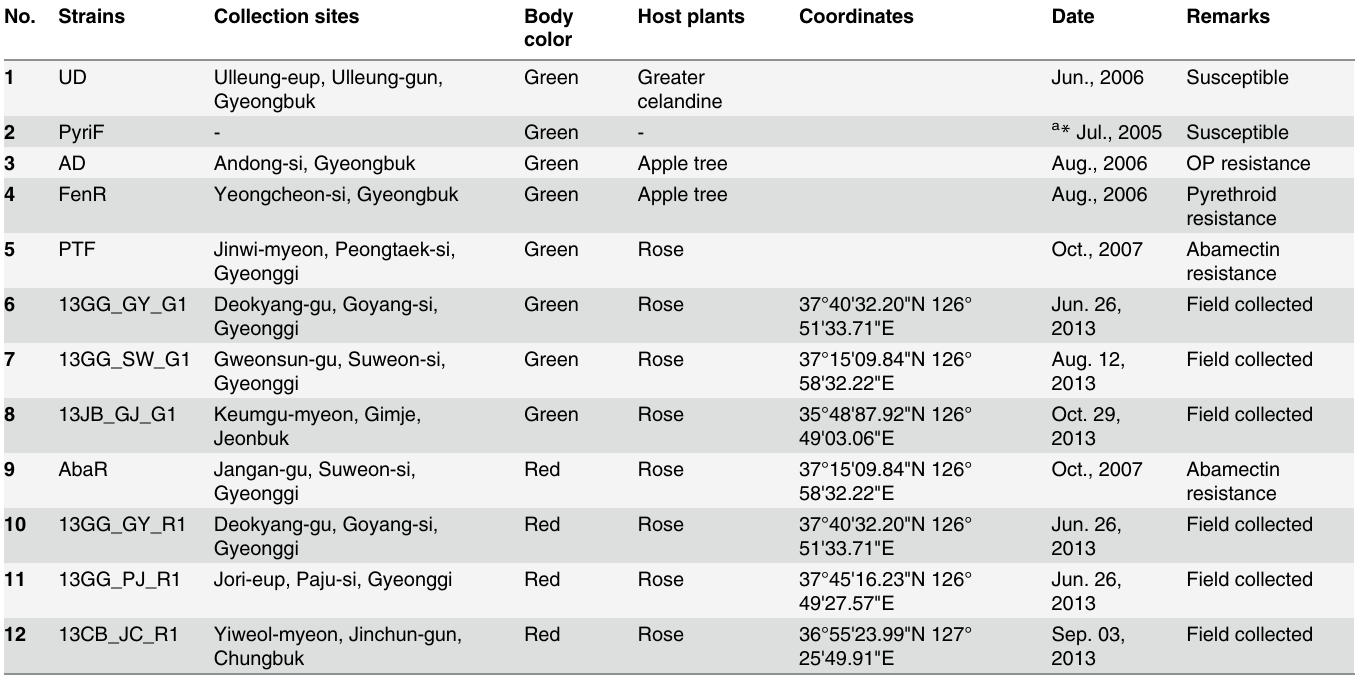
Table 2. Tetranychus urticae collection